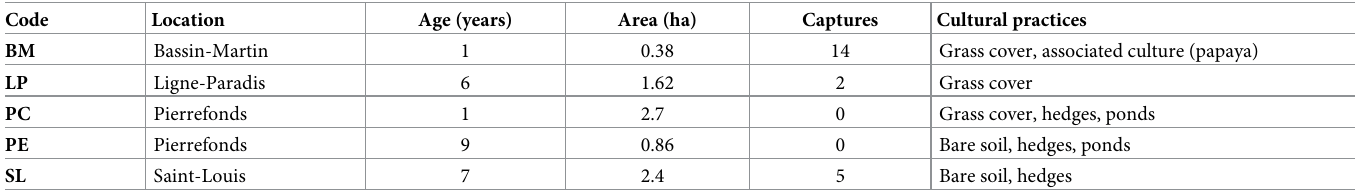
Table 1. Background information for the five plots. Age indicates the number of years that bananas were continuously grown in the plot. Captures indicates the number of weevils captured in the plot in the 2-month period before the study began. Under Cultural practices, hedges are mostly represented by sugarcane. Code